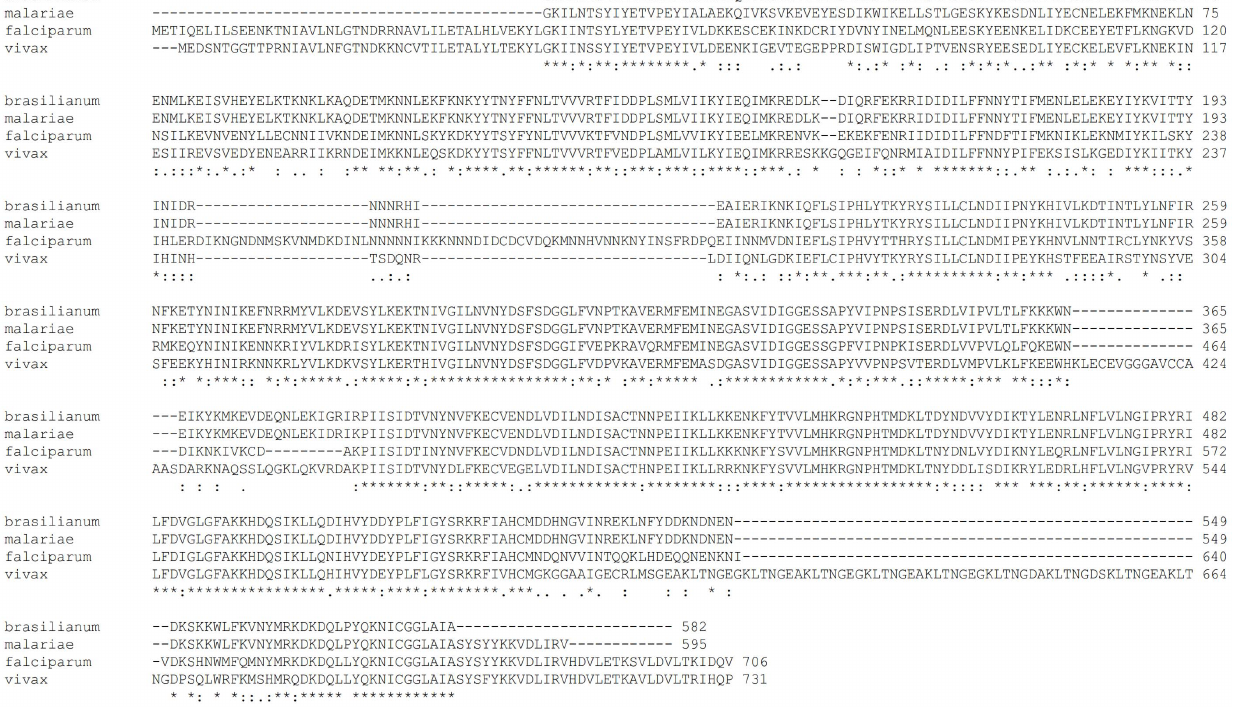
Figure 1. Deduced partial PPPK-DHPS amino acid sequences alignment. doi:10.1371/journal.pone.0093942.g001 PLOS ONE |